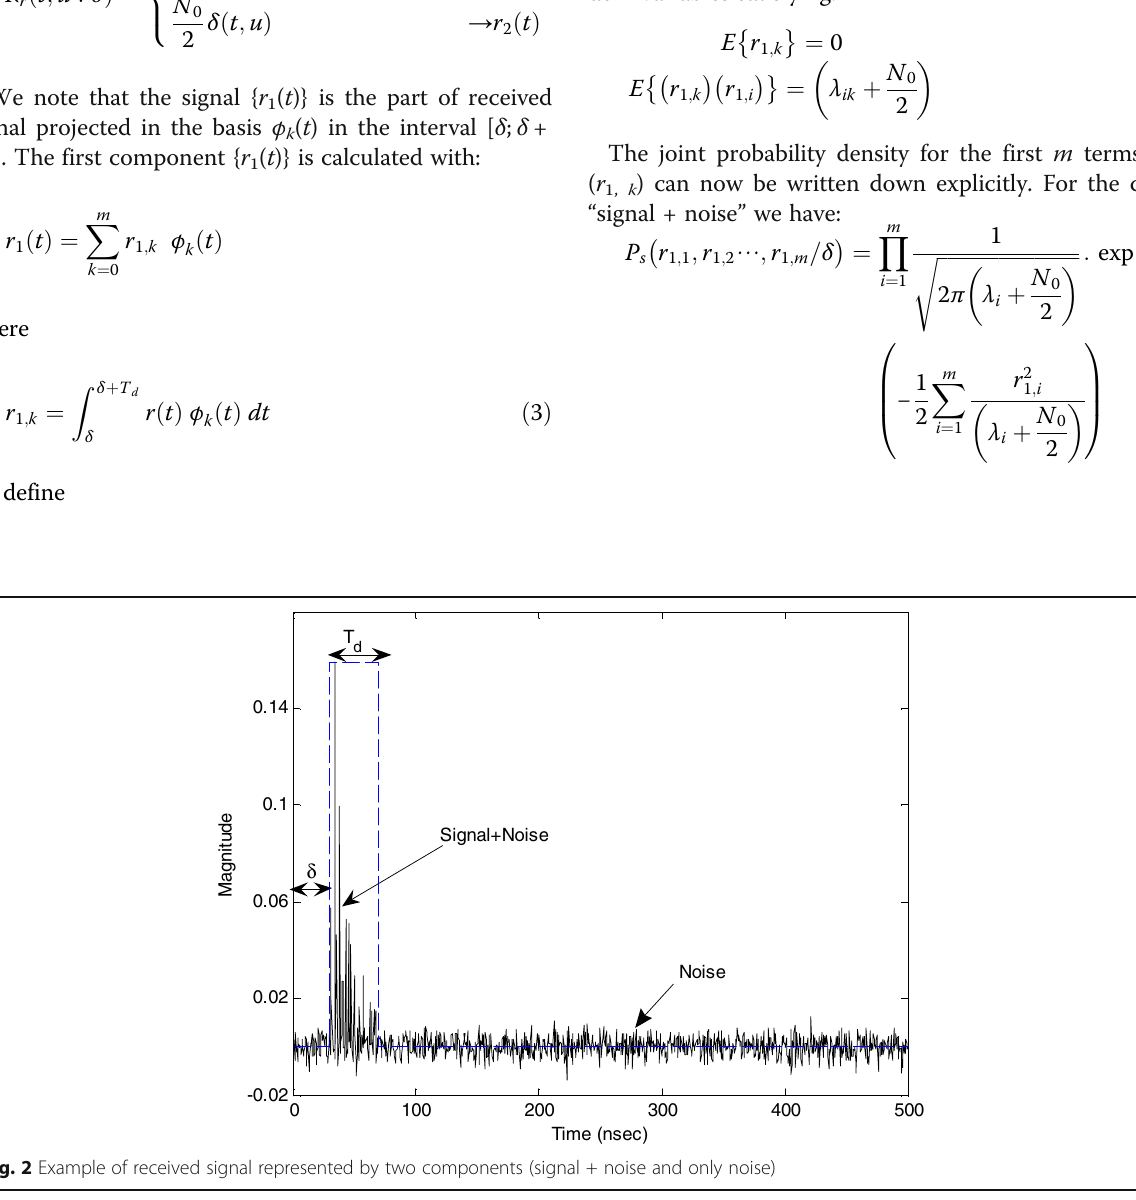
Fig. 2 Example of received signal represented by two components (signal + noise and only